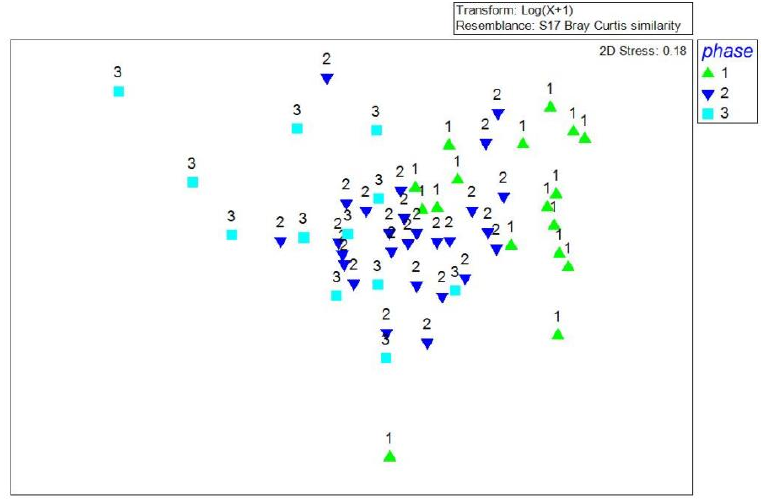
Figure 8. MDS ordination of 56 samples in the growth (1), maintenance (2), and dissipation (3) phases of P. donghaiense bloom using the Bray Curtis similarities on log-transformed abundance data.